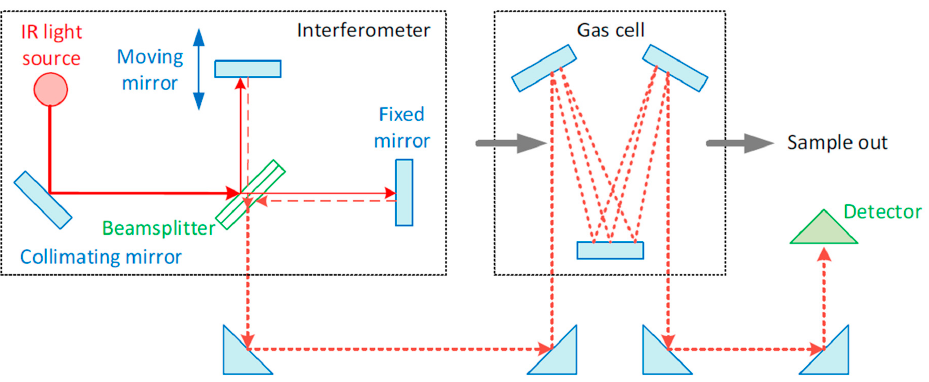
Figure 3. Diagram of the principle of operation of an infrared FTIR spectroscope. Reprinted with permission from Ref. [25] (2021). The Michelson interferometer is the first model of interferometers, and it is the most commonly used. Using a collimating mirror, the sensor makes the light rays coming from the sample parallel, and the light acts on a beam splitter, where some of the rays are transmitted and the others are reflected. The transmitted light splits and hits both a fixed mirror and a moving mirror. The two light beams are recombined into a single light beam due to the reflection of the two mirrors back to the beam splitter. The single-beam passes through the object under examination and finally strikes the detector. In the interferometer, there are two rays, one has a fixed length and the other continuously changes its length due to the moving mirror, the interference between these two signals is the result obtained with the interferometer. The results are shown through an interferogram, and to obtain a spectrum, the signal must be mathematically transformed with Fourier. This is one of the spectroscopy methods used in the study of W. Gill et al.